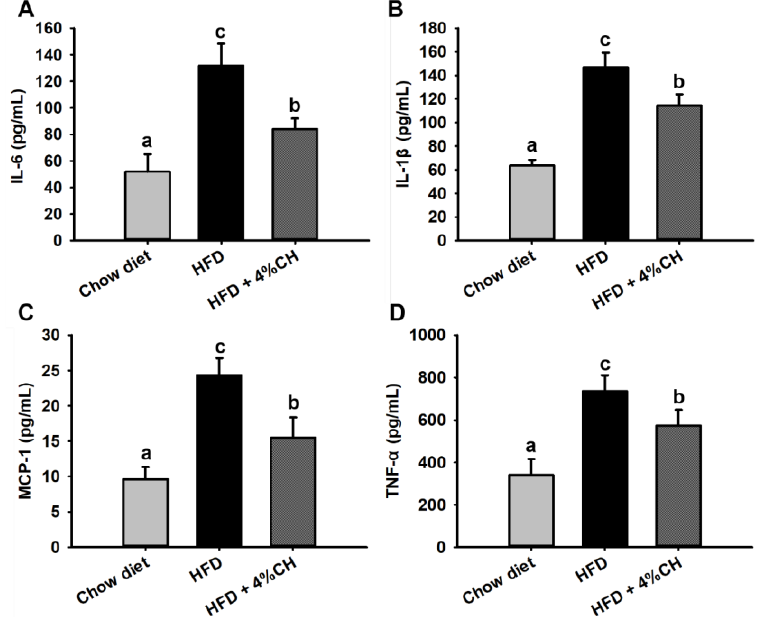
Figure 5. The effects of CH supplementation on the serum inflammatory factors in HFD-induced obese mice. The level of IL-6 ( A ), IL-1β ( B ), MCP-1 ( C ) and TNF-α ( D ) in the serum of mice. All data were shown as means ± SD ( n = 12). Data sharing the different superscript letters in each column indicated that the difference between each group was statistically significant at p < 0.05.